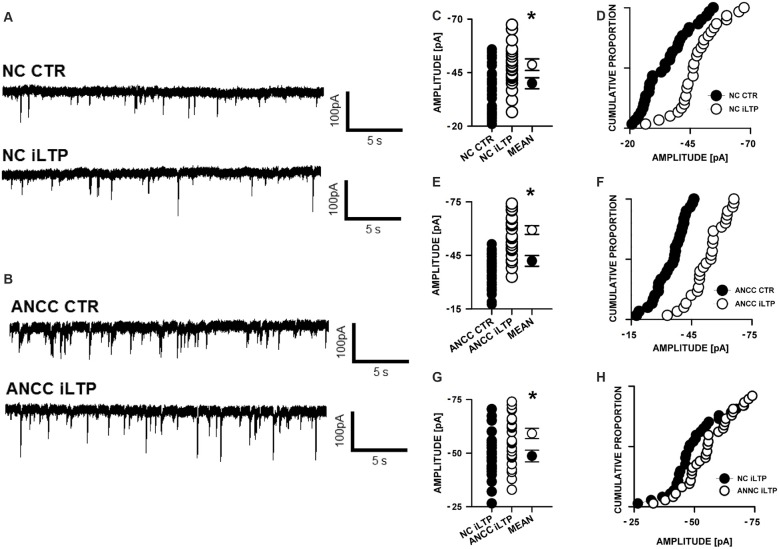
Supplementation of neuronal cultures (NC) with astrocytes strongly upregulates inhibitory long-term potentiation (iLTP). (A) Typical traces obtained in NC. (B) Typical traces from astrocyte-neuronal co-culture (ANCC), upper one present control measurement, lower one after iLTP induction. (C,D) Comparisons of mIPSC amplitude values obtained in NC with or without iLTP induction. (E,F) Comparisons of mIPSC amplitude values obtained in ANCC with or without iLTP induction. (G,H) Comparisons of mIPSC amplitude values obtained in NC and ANCC with iLTP induction. Statistical significant results in scatter plots (p < 0.05) are represented with star mark.